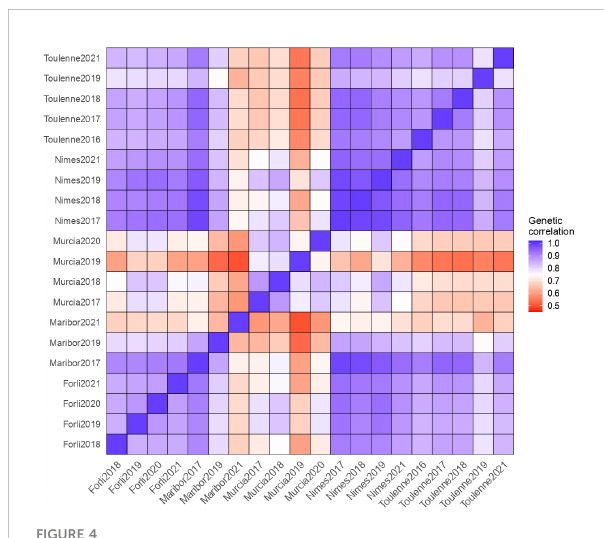
FIGURE 4 Matrix of pair-wise genetic correlations for beginning of fl owering